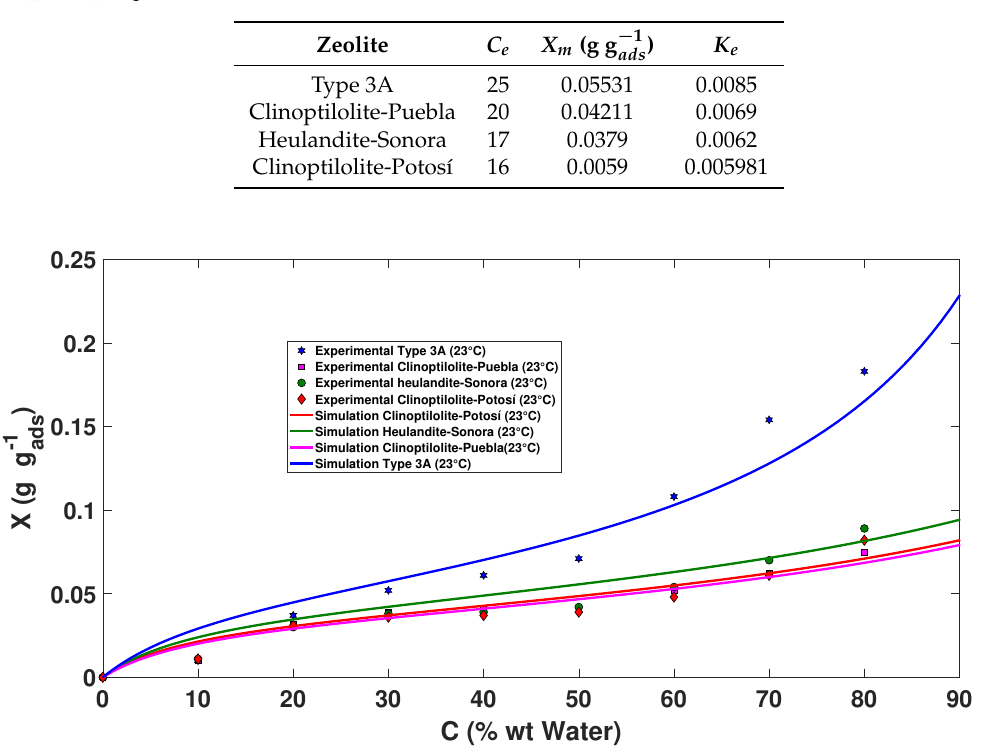
Values of the thermodynamic constants as a function of temperature for the H 2 O / H 2 SO 4 mixture.